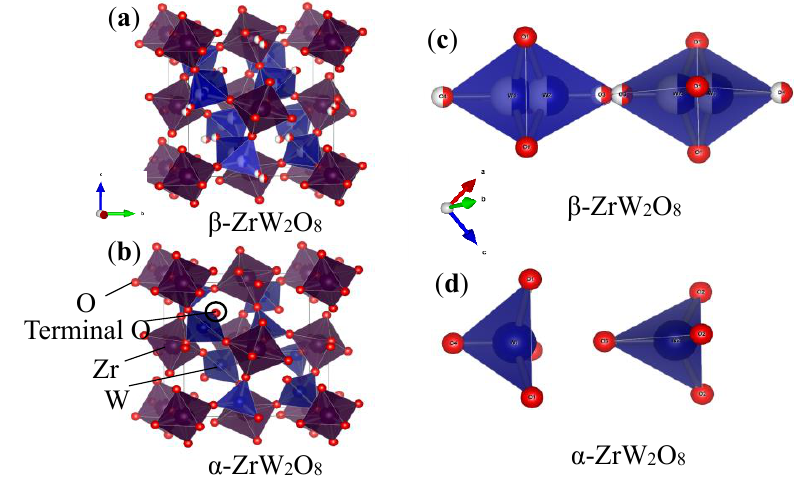
Figure 8. Crystal structure of ( a ) α phase and ( b ) β phase of ZrW 2 O 8 ; WO 4 groups in <111> direction of ( c ) α phase and ( d ) β phase of ZrW 2 O 8 .